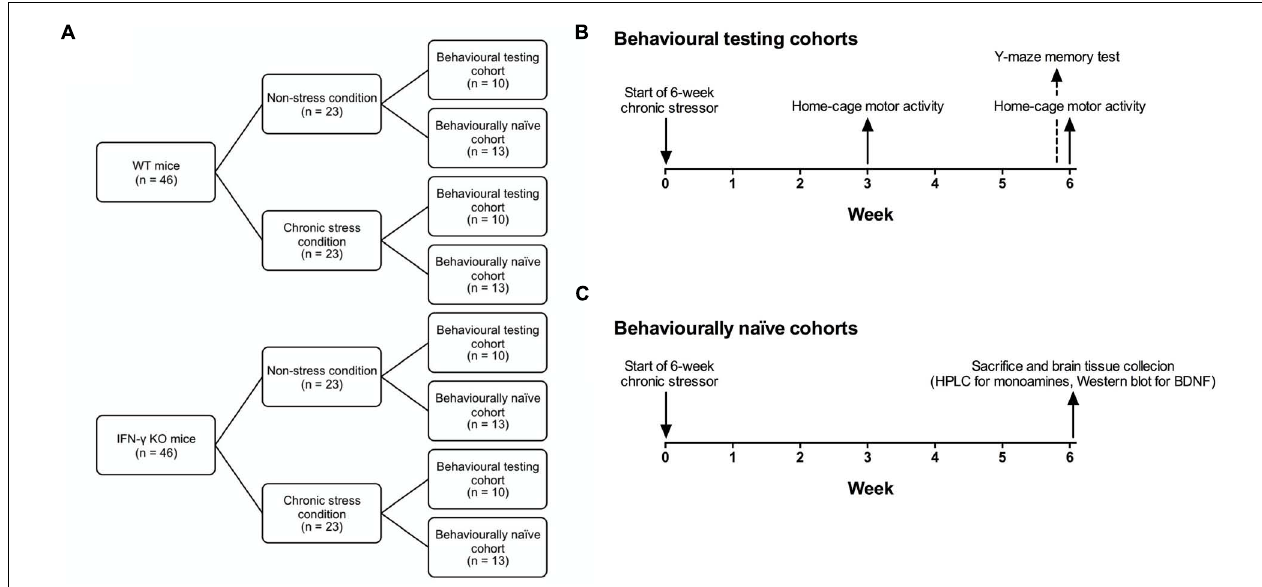
FIGURE 1 | Schematic showing the experimental design and timeline. IFN- γ knockout (KO) and wild-type (WT) littermate mice ( n = 46 per genotype) were randomly assigned to a 6-week chronic stressor condition or a non-stress control group ( n = 23; A ). Mice of each